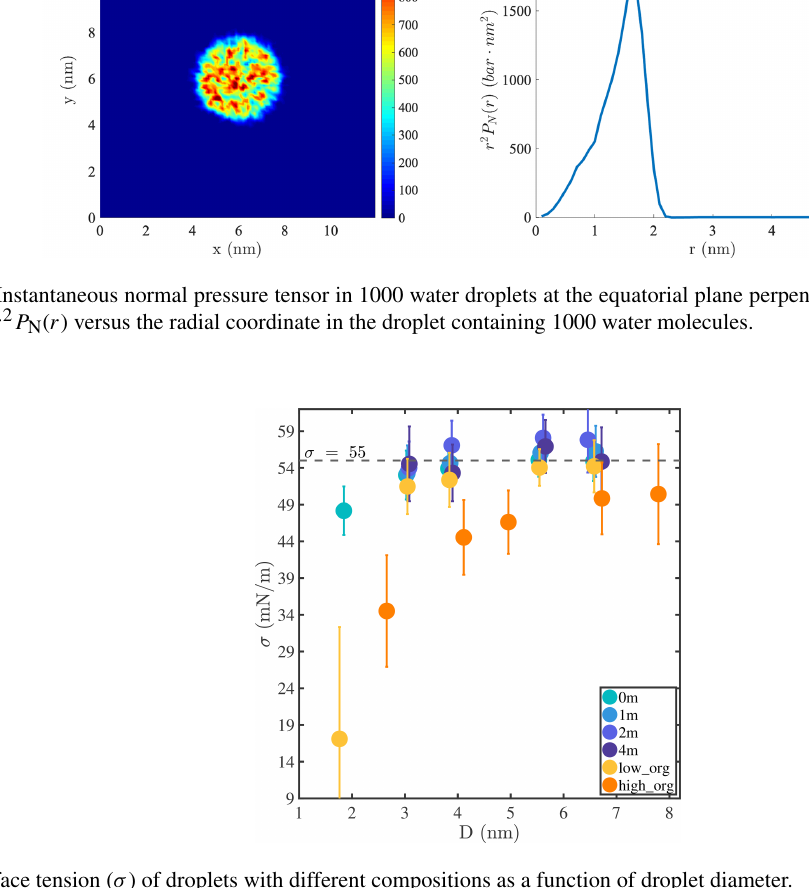
Atmos. Chem. Phys., 23, 2525–2556, 2023